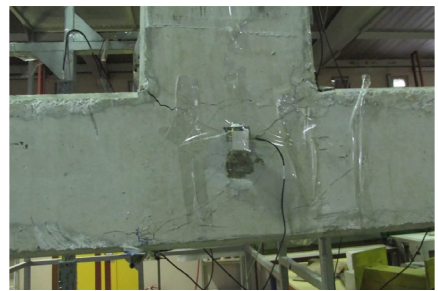
Figure 15: Failure of the target sample.